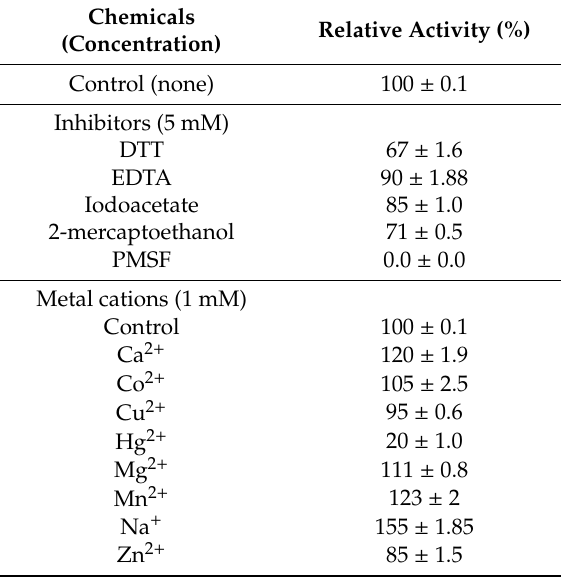
Table 3. Impact of di ff erent inhibitors, metal cations, solvents, and surfactants on the protease